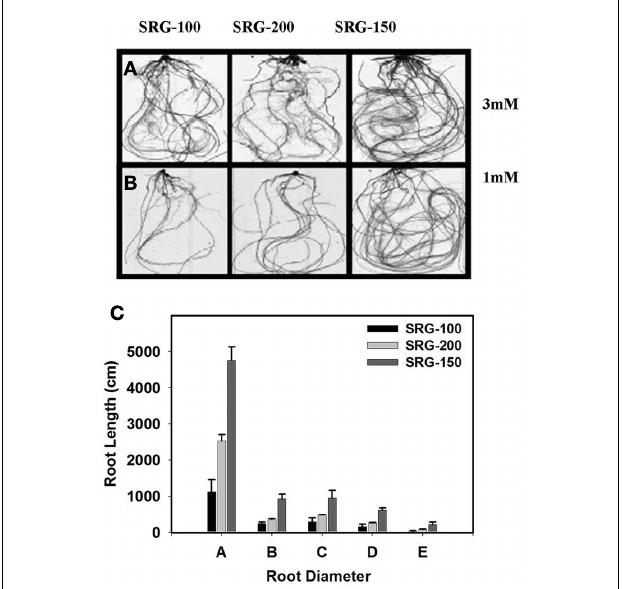
FIGURE 3 | N limitation effect on root system of the maize hybrid SRG-150 and its parents lines SRG-100 and SRG-200. Images were taken by theWinRHIZO system, (A) plants grown at 3mM; (B) plants grown at 1mM. (C) Roots length of the different parts of the root system under N limitation, classified based on the diameter (A = 0–0.3; B = 0.3–0.5; C = 0.5–1; D = 1–2; E = 2–5mm). Data are means ± SD ( n = 3). Bars with different letters indicate a significant difference at P ≤ 0.05 (Tukey’s Honestly Significant DifferenceTest).